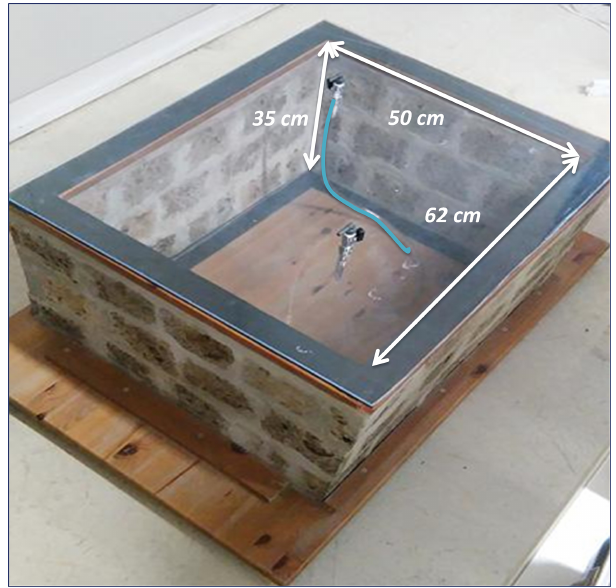
Figure 1. The scale model-room of 62cm × 50cm × 35cm (in- ner length × width × height), made of “Tufo di Gallese” ignimbrite (Caprarola area, central Italy). Two taps are installed on the Plexi- glas roof of the room to introduce and/or extract air from the cham-